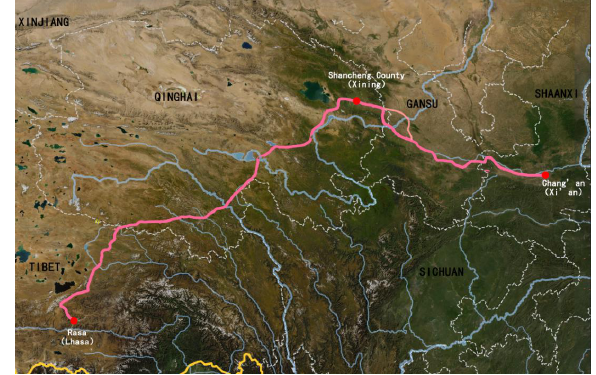
Figure 3. Tang-Tibet Road’s